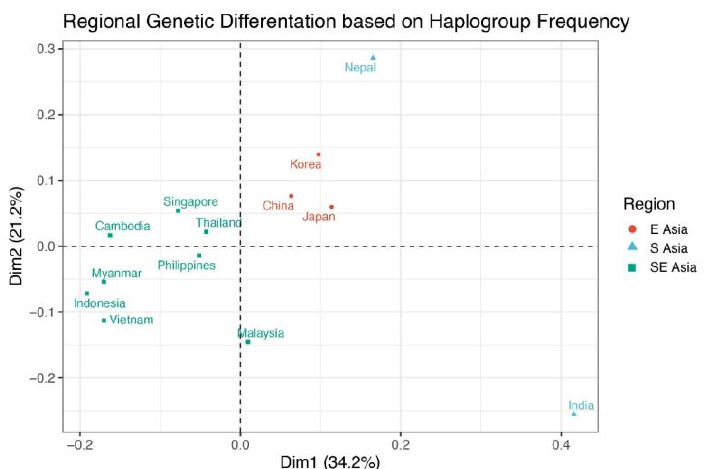
Figure 5. Principal component analysis based on haplogroup frequencies.